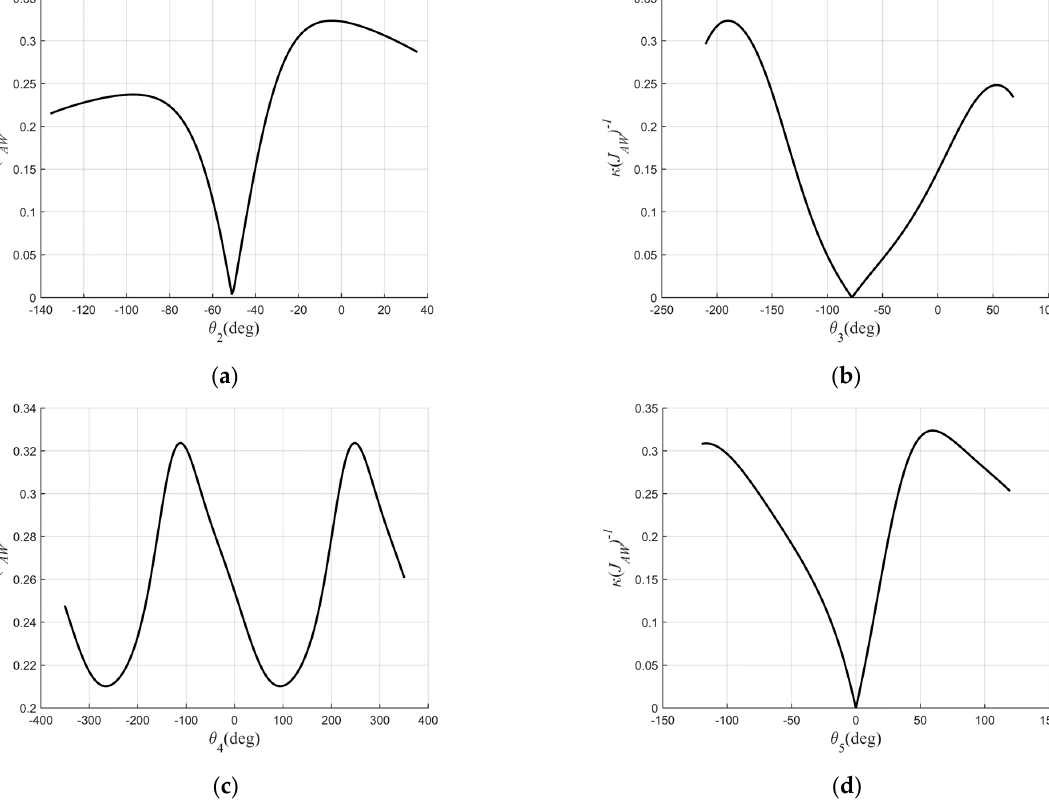
( J ) − 1 . ( a ) The influence of joint 2 on κ ( J AW